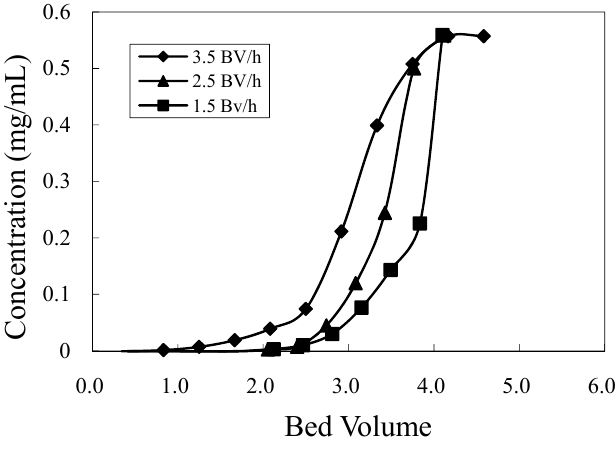
Figure 5. Dynamic breakthrough curve of mogroside V on HZ 806 resin.